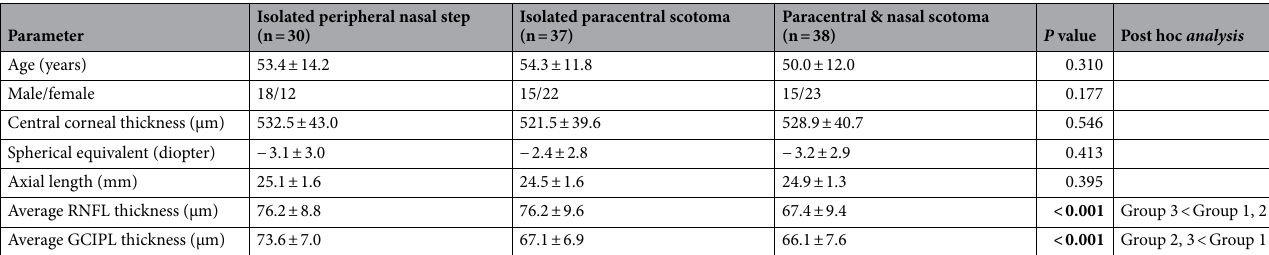
Table 1. Characteristics of glaucoma patients. Statistically significant values ( P < 0.05) are shown in bold. GCIPL, ganglion cell-inner plexiform layer; RNFL, retinal nerve fiber layer. Continuous variables are expressed